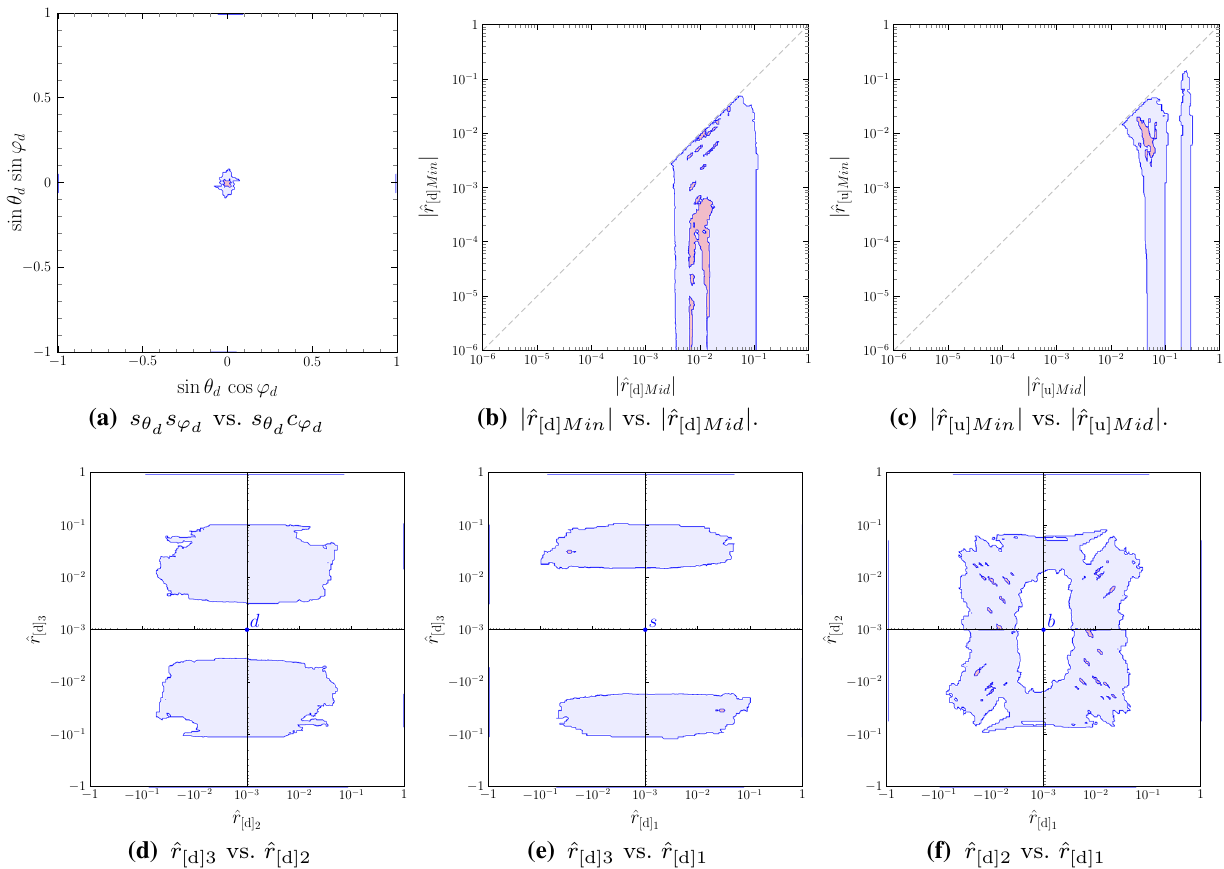
( 1 − loop ) ( 1 − loop ) < ; in red, requiring θ QFD QFD